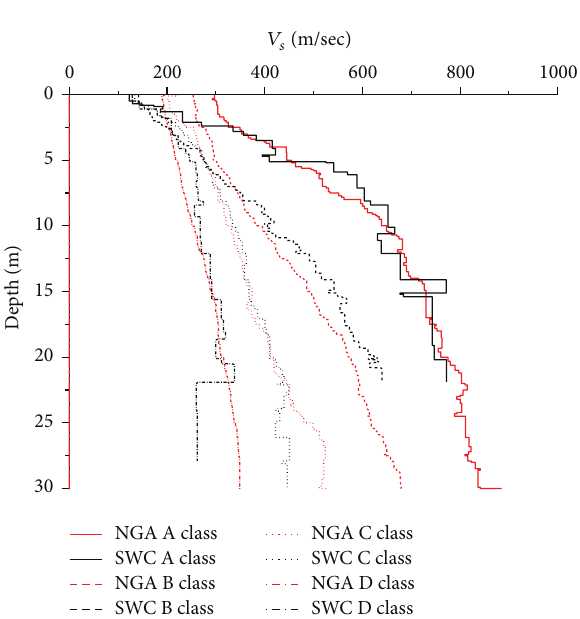
Figure 2: Comparison of median 𝑉 𝑠 between Southwest China (SWC) profiles and NGA